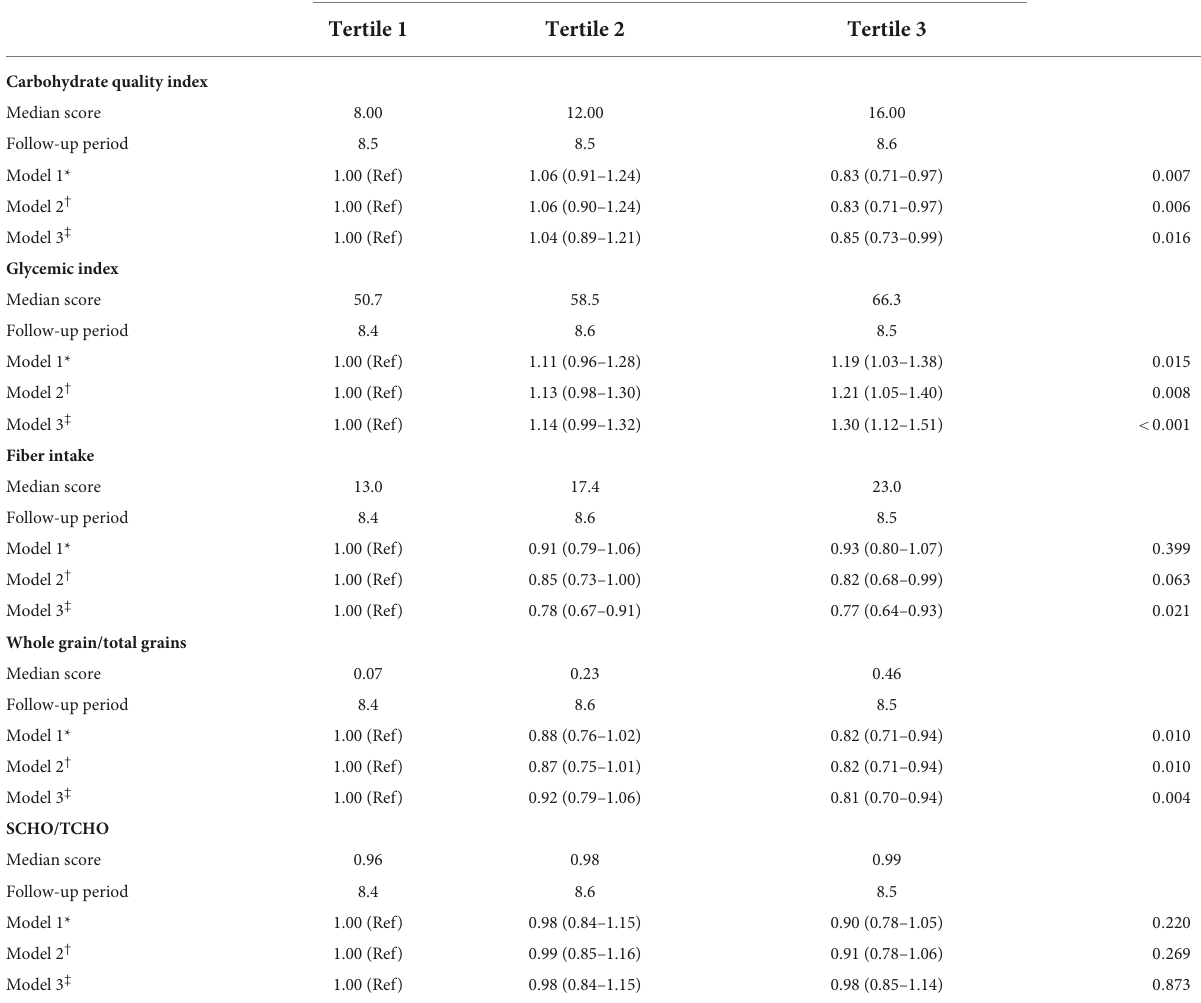
Dietary indices Carbohydrate quality index score and its components P trend